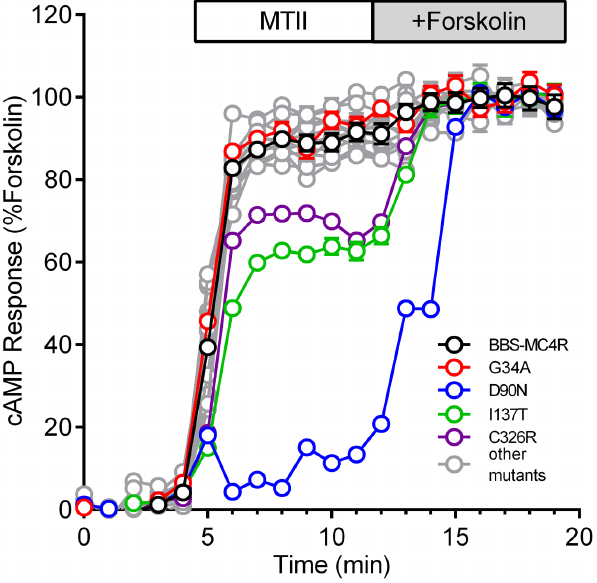
Figure 4. cAMP Assay of MC4R mutants. cAMP production of MC4R mutants after stimulation with 10 nmol/L melanotan II (MTII) and then 100 m mol/L forskolin to activate maximum receptor-independent cAMP response. MTII stimulation was normalized to baseline cAMP production and plotted as a percentage of forskolin in the same cell. Mutants similar to wild-type (Black # ) are designated with the symbol (Gray # ). MC4R novel mutant G34A (Red # ) and those that have different statistically altered cAMP signaling (p , 0.01 compared to wild- type by a one way ANOVA with Dunnet’s post hoc test) (I137T (Green # ), D90N (Blue # ) and C326R (Purple # )) are highlighted with different colored symbols. The D90N variant was not found in this cohort, but included as a